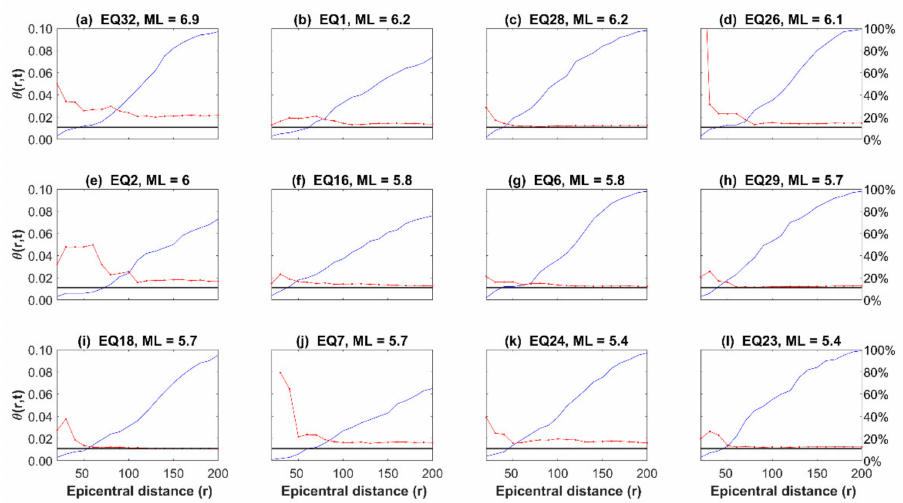
Figure 7. Variations of θ (r, t) for 12 events sorted by earthquake magnitude. The red lines show θ (r, t) , and the blue lines show the percentage of GPS stations with epicentral distance < r . The horizontal black lines indicate the anomalous band of